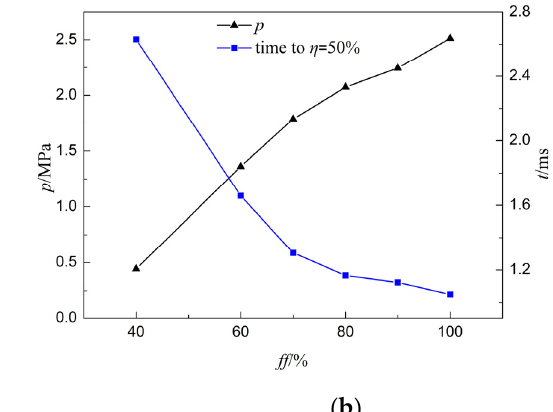
10 of 14 Figure 8. Radiation signal intensity of detonation and deflagration.